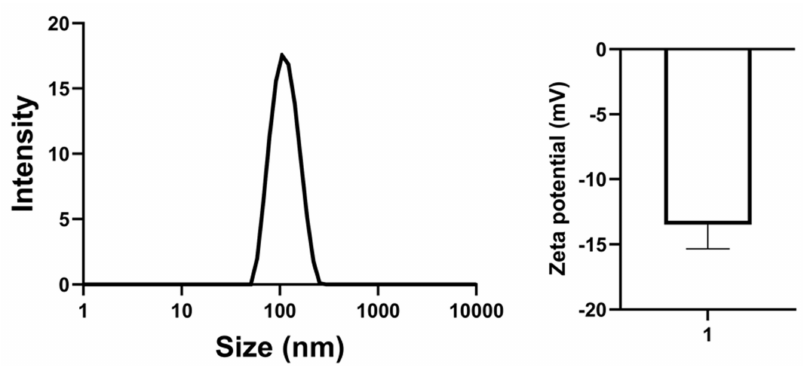
Figure 3. Particle size and zeta potential of compound 4d liposome.